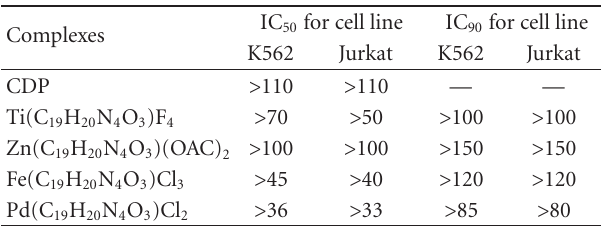
Table 1: 72-hour IC 50 and IC 90 values ( μ M) obtained for CDP and three CDP complexes. IC 50 for cell Complexes